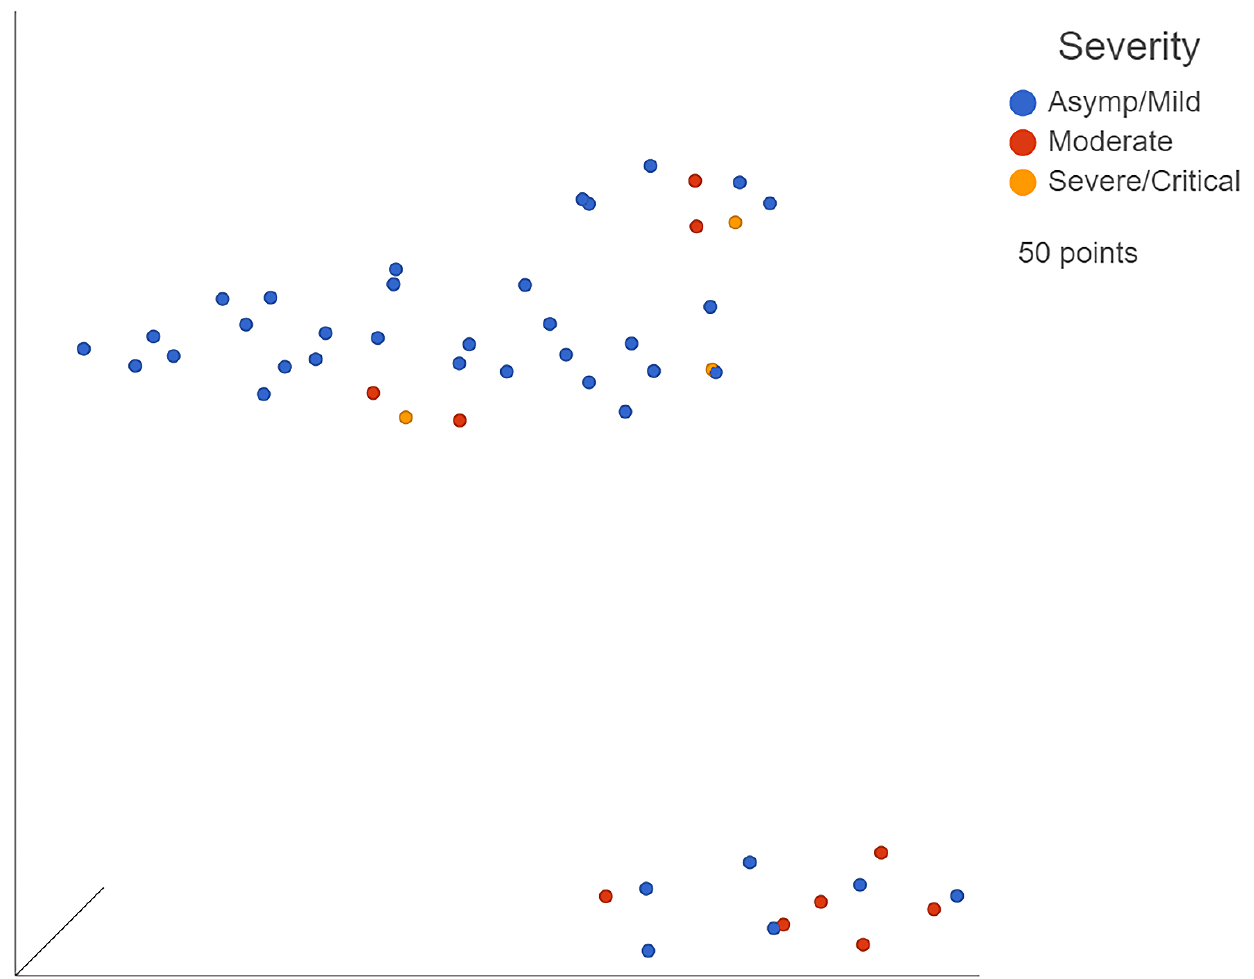
Figure 3. UMAP of GSE162835 classifications. Blue points represent mild, yellow moderate, and red severe patients. Generated in Partek Flow.